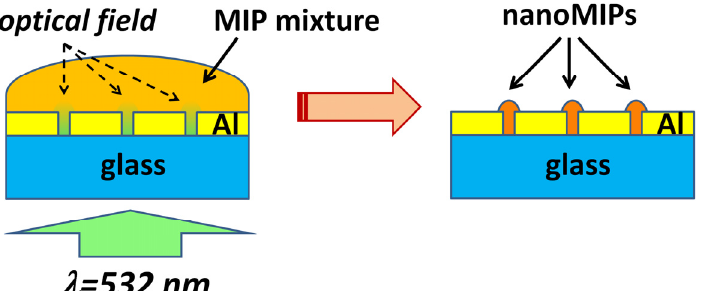
Figure 8. Schematics of the synthesis of nanoMIPs in Al nanoholes by local photopolymerization. ( Left ) A prepolymerization MIP mixture, containing a